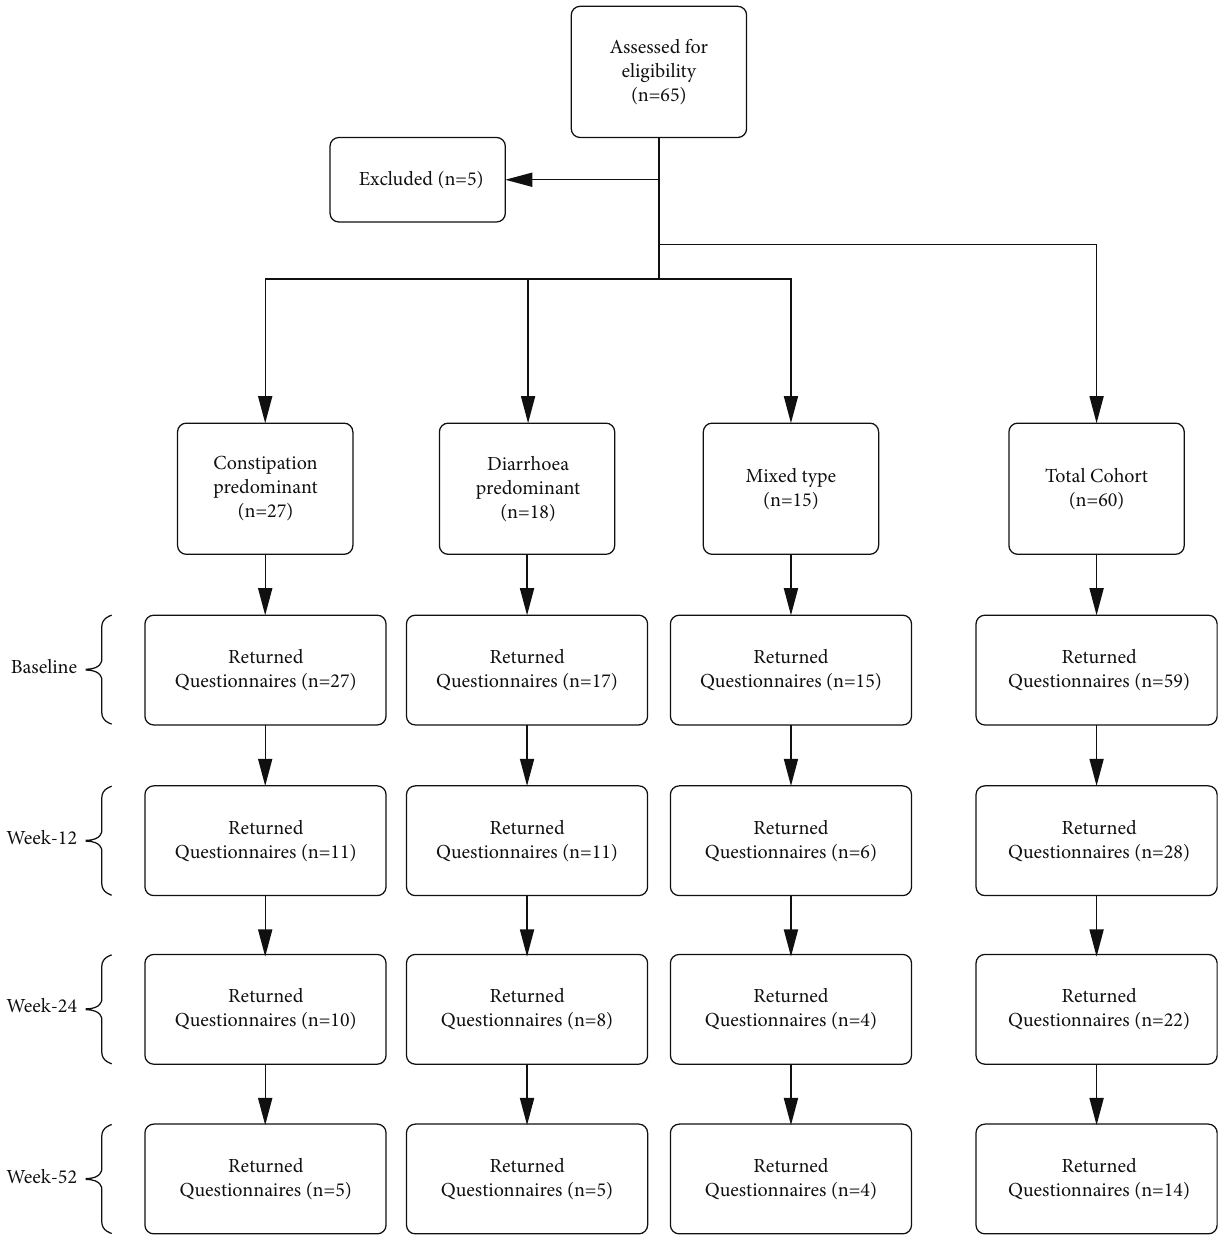
Figure 1: Participant inclusion and questionnaire response rate fl owchart for the total cohort and IBS